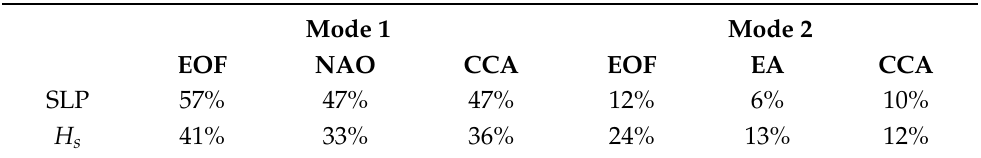
Table 2. Percentage of variance explained by each method (EOF, NAO, or EA index, CCA) for the leading mode (mode 1) and the second mode (mode 2) of SLP and H s